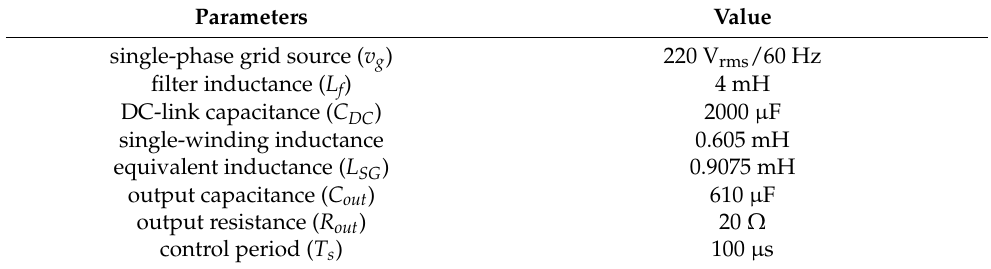
Table 2. Simulation parameters.